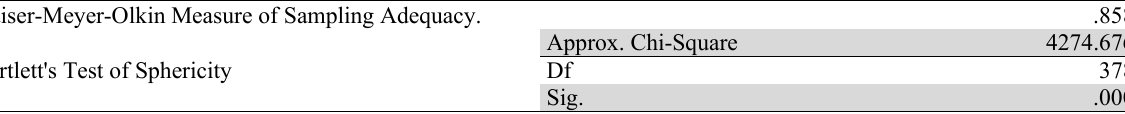
KMO and Bartlett's Test